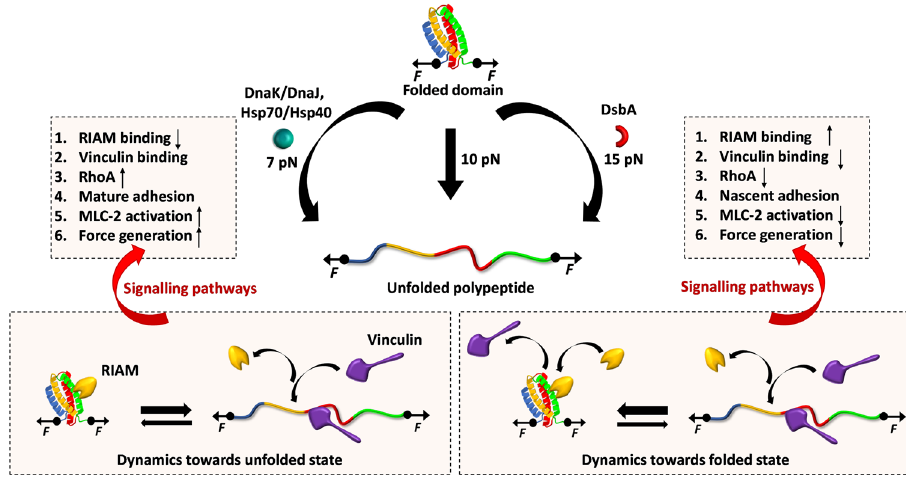
Fig. 9 Plausible in vivo effect of Chaperone-modulated mechanical stability of talin. Talin rod domains exhibit strong tension-dependent conformational changes which can further be modulated by both classes of chaperones: unfoldase and foldase. In the absence of chaperones, R3 unfolds at 10 pN force while it shifts to 15 pN or 7 pN, in the presence of foldase and unfoldase chaperones, respectively. This altered-mechanical stability could in fl uence cellular physiology by tuning the downstream signaling pathways. Unfoldases such as Hsp70 and Hsp40 shift the folding dynamics of R3 domain towards the unfolded state, thereby, favoring the RIAM dissociation and vinculin interaction. Subsequently, this induces RhoA signaling, downstream MLC-2 activation, and thus, enhances the force generation at growing adhesion to facilitate cell migration. By contrast, foldase (DsbA) shifts the folding dynamics towards the folded state which subsequently promotes RIAM binding to the talin domains and localization in nascent adhesion. This negatively regulates the RhoA pathway which in turn abrogates MLC-2 activation, force generation, and cell